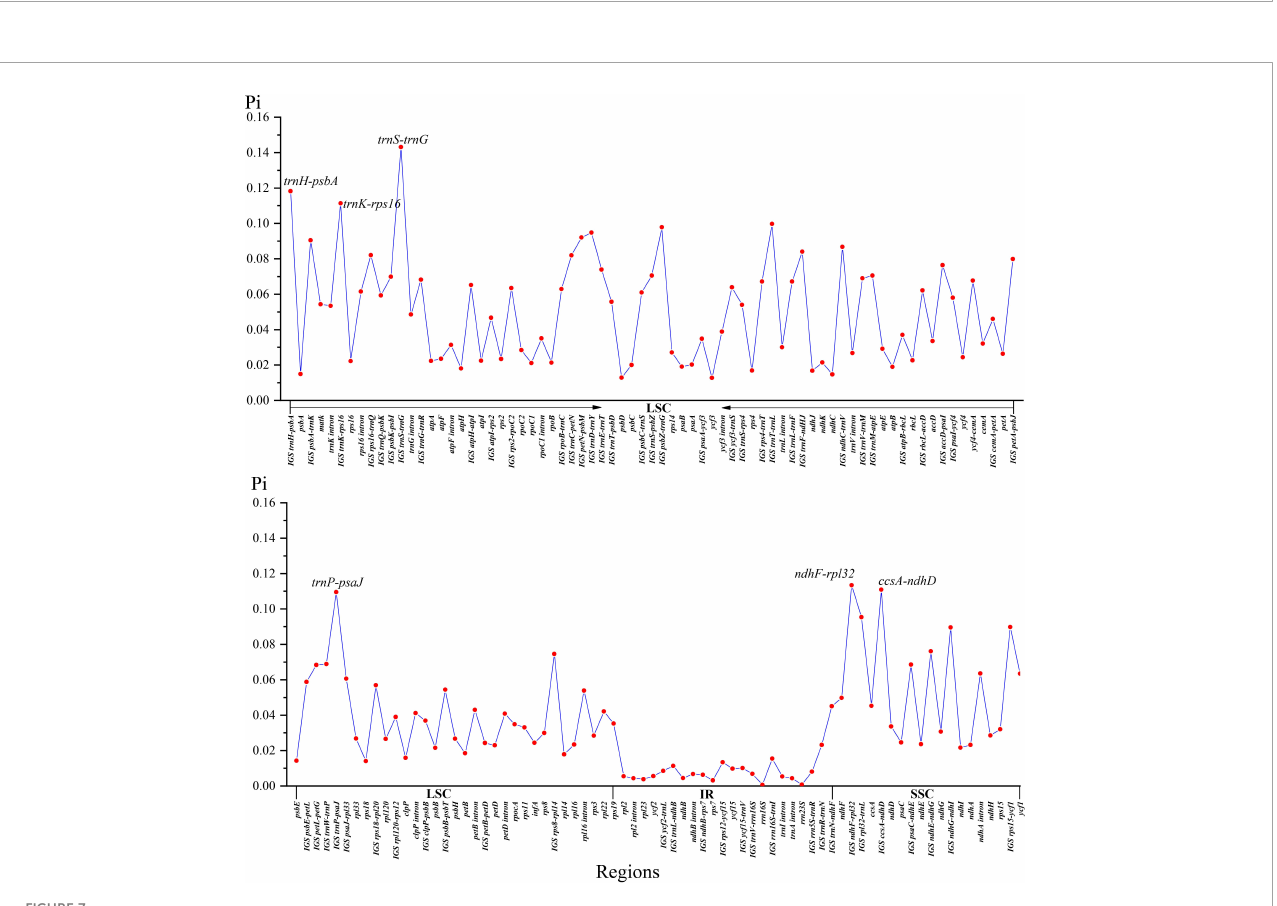
FIGURE 7 Nucleotide diversity ( Pi ) values of 12 Menispermaceae plastome